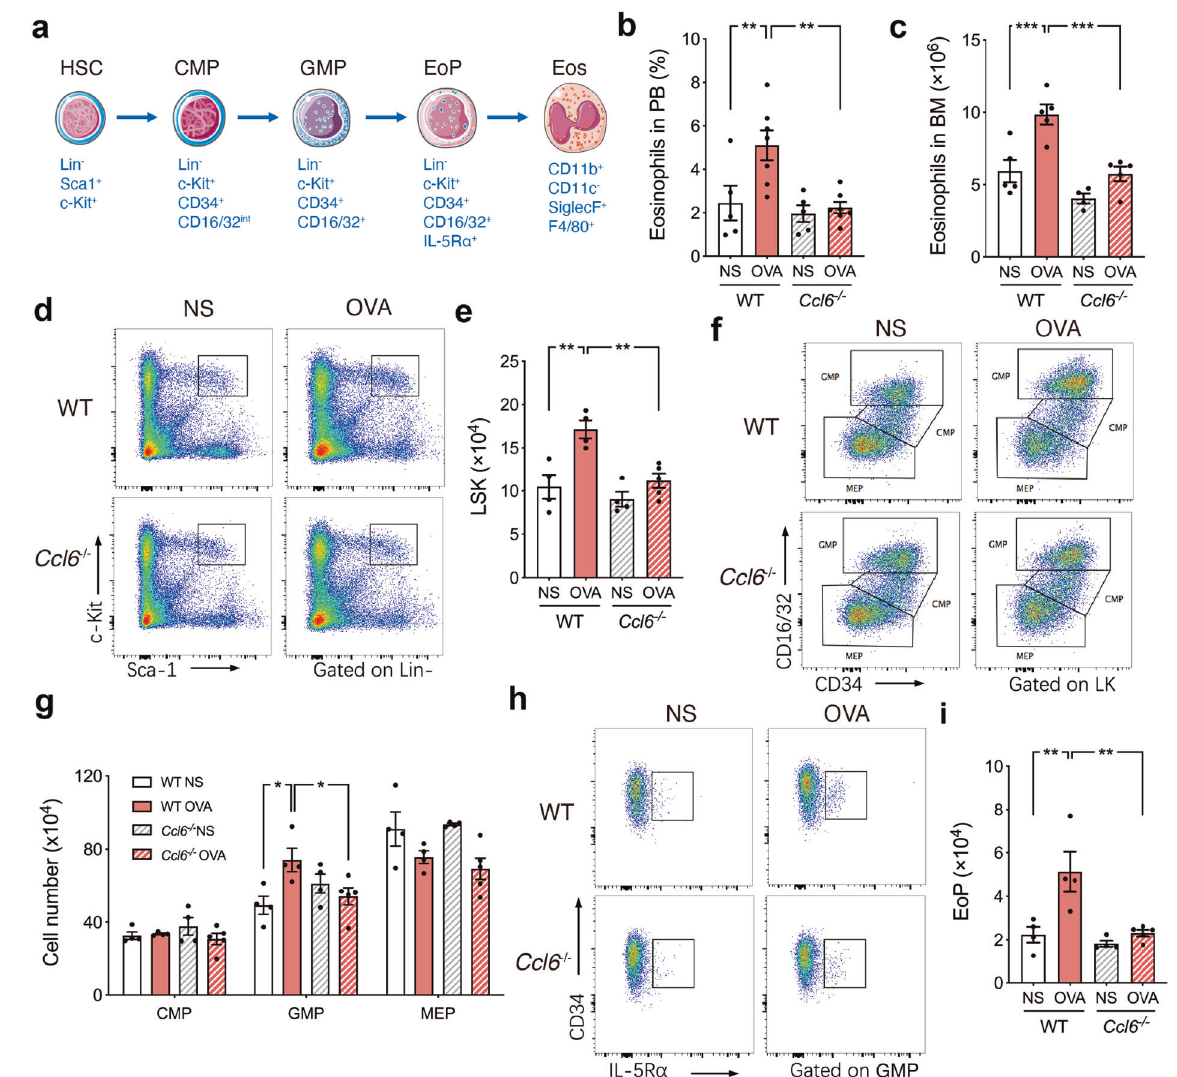
Fig. 4 CCL6 de fi ciency abolishes the impairment of HSC homeostasis in allergen-induced airway in fl ammation. a Murine eosinophil differentiation hierarchy. b-c Quantitative number of eosinophils in peripheral blood ( b ) and bone marrow ( c ) of NS or OVA-challenged WT and Ccl6 -/- mice. d-e Representative fl ow cytometric dot plots ( d ) and quantitative number ( e ) of LSK. f-g Representative fl ow cytometric dot plots ( f ) and quantitative number ( g ) of CMP, GMP, MEP. h , i Representative fl ow cytometric dot plots ( h ) and quantitative number ( i ) of EoP. Data are statistically calculated as mean ± SEM for 4 – 6 mice in each group from three independent experiments. * P < 0.05; ** P < 0.01; *** P < 0.001 by one-way ANOVA with Sidak ’ s multiple comparisons